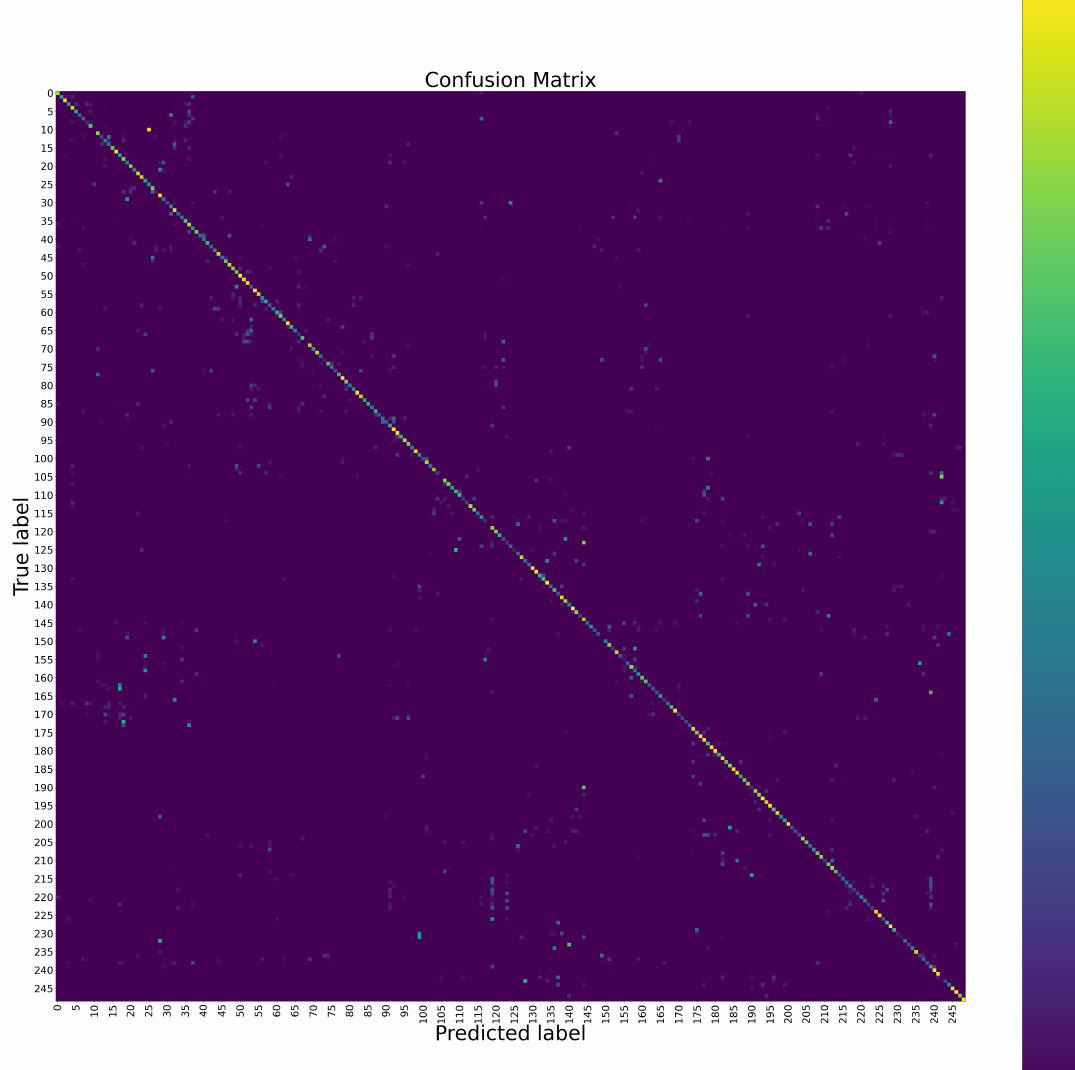
Figure 5. The confusion matrix of the proposed method at the body level on the Chalearn LAP IsoGD dataset. To see the details, please zoom